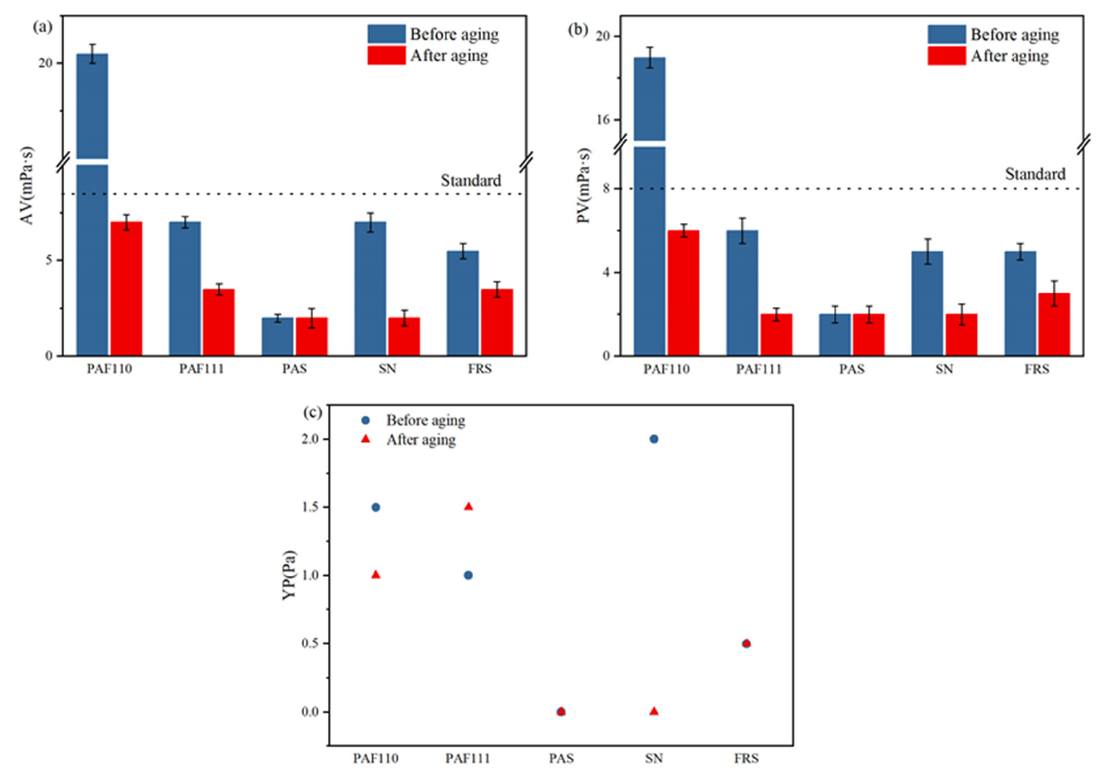
Figure 8. The rheological parameters of all samples before and after aging: ( a ) AV; ( b ) PV; ( c ) YP.